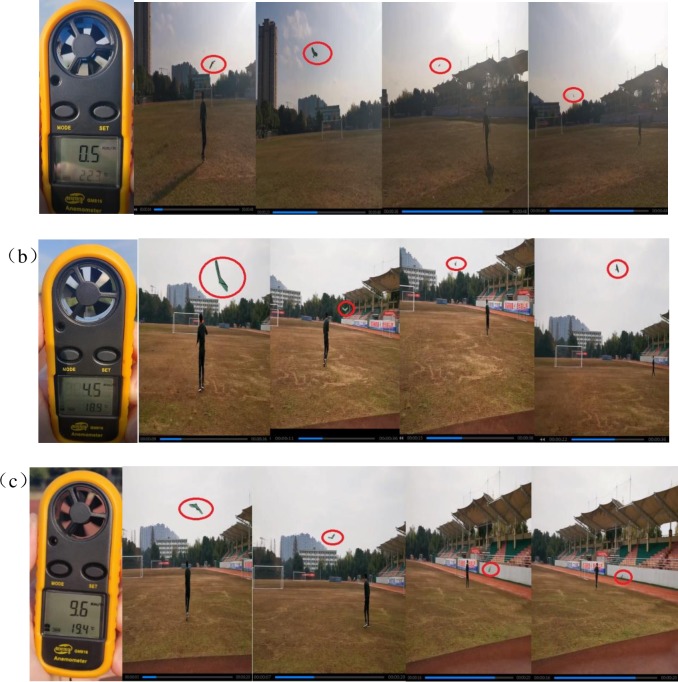
The flight experiments of the robot under different wind speeds, where (a): under the maximum wind speed v1 = 0.5(km/h), (b): under the maximum wind speed v2 = 4.5(km/h), and (c): under the maximum wind speed v3 = 9.6(km/h).